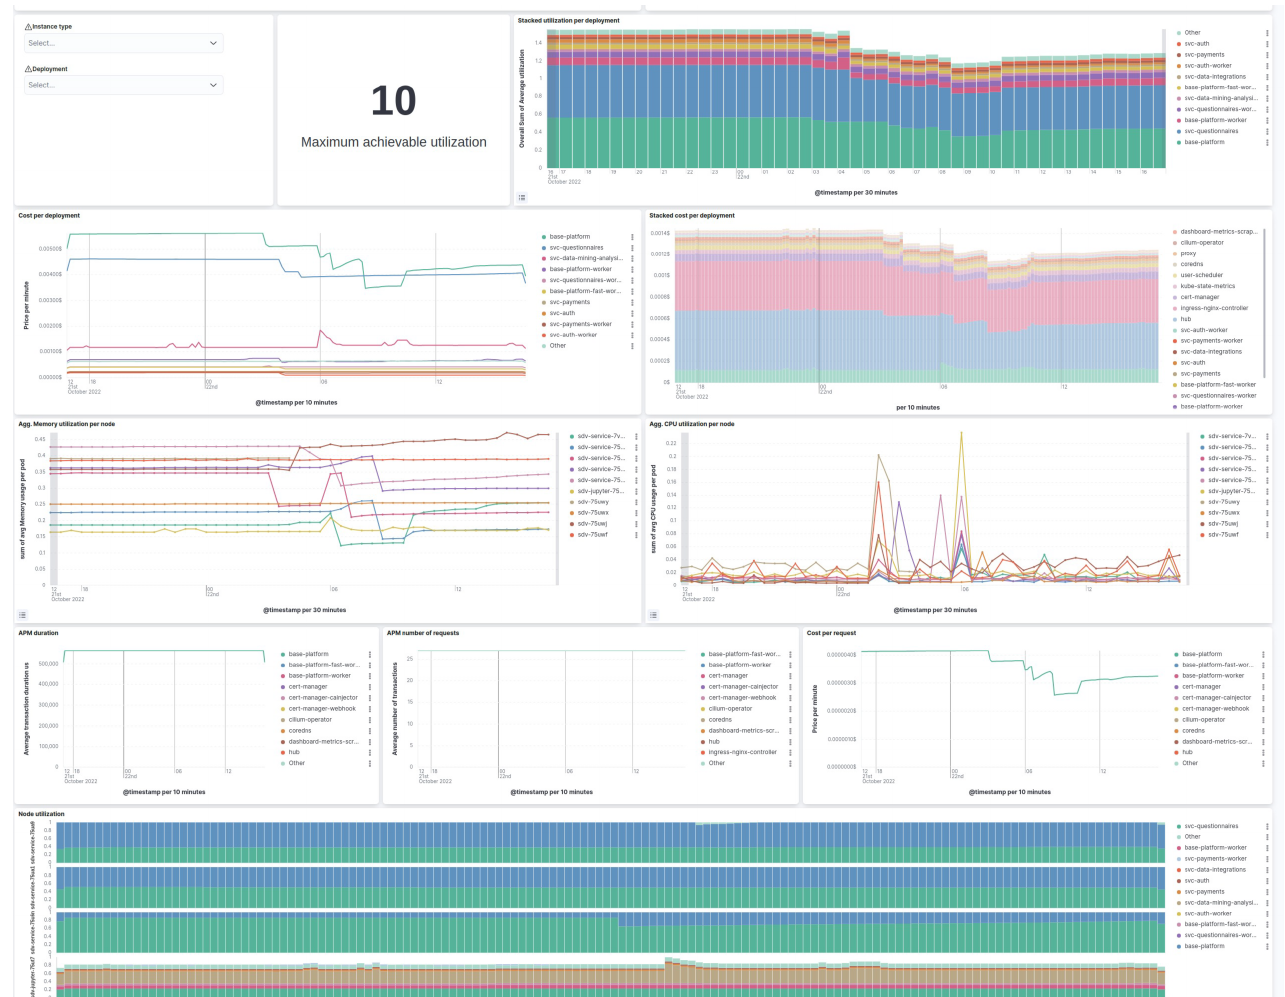
Figure 4. Partial, zoomed-out view of the CPT dashboard with data from a specific deployment of the data platform. Cost-specific charts are offered in addition to the expected utilization-driven